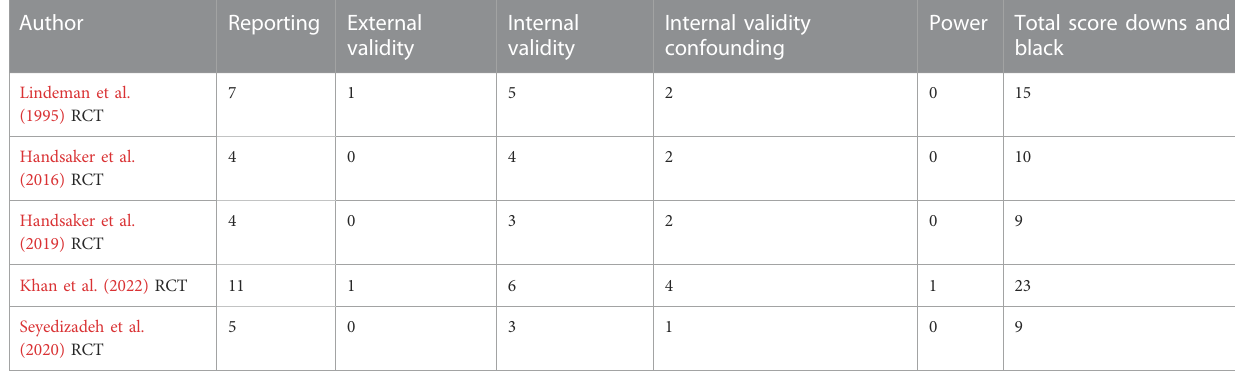
TABLE 3 Sum of quality assessment of randomized controlled trials — Downs and Blacks